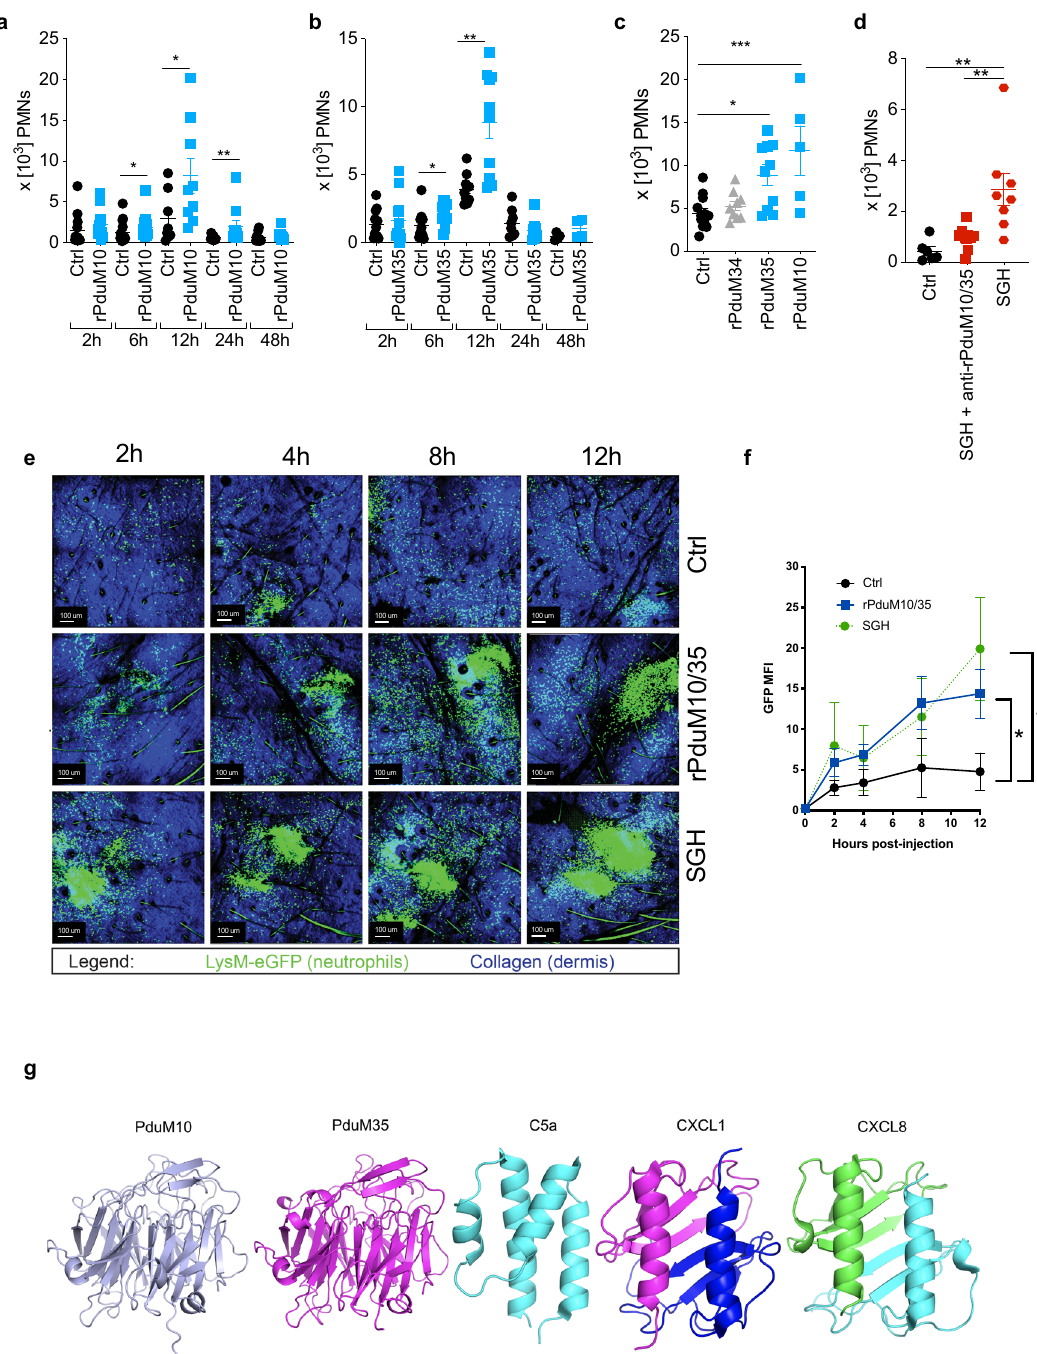
and rLJM11/17 (Fig. 2k) was abrogated in the transwell assay. Interestingly, pretreatment of neutrophils with wortmannin, a pan-PI3K inhibitor, abolished migration to rPduM10/35 (Fig. 2j), but some migration towards rLJM11/17 persisted (Fig.